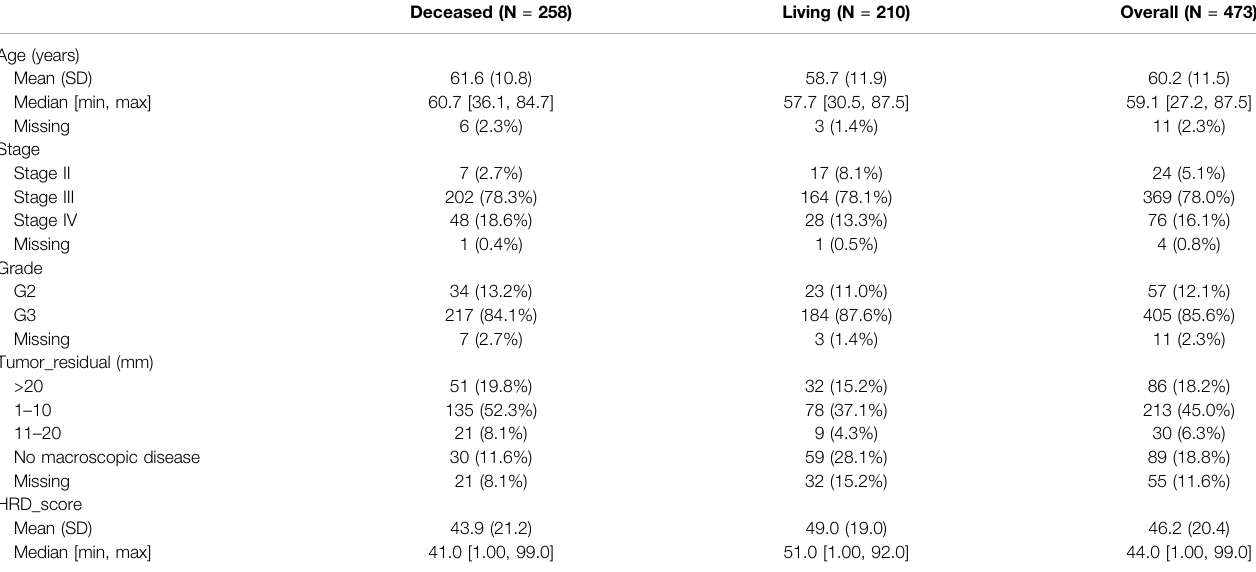
TABLE 1 | Clinical information of 473 high-grade serous ovarian adenocarcinoma